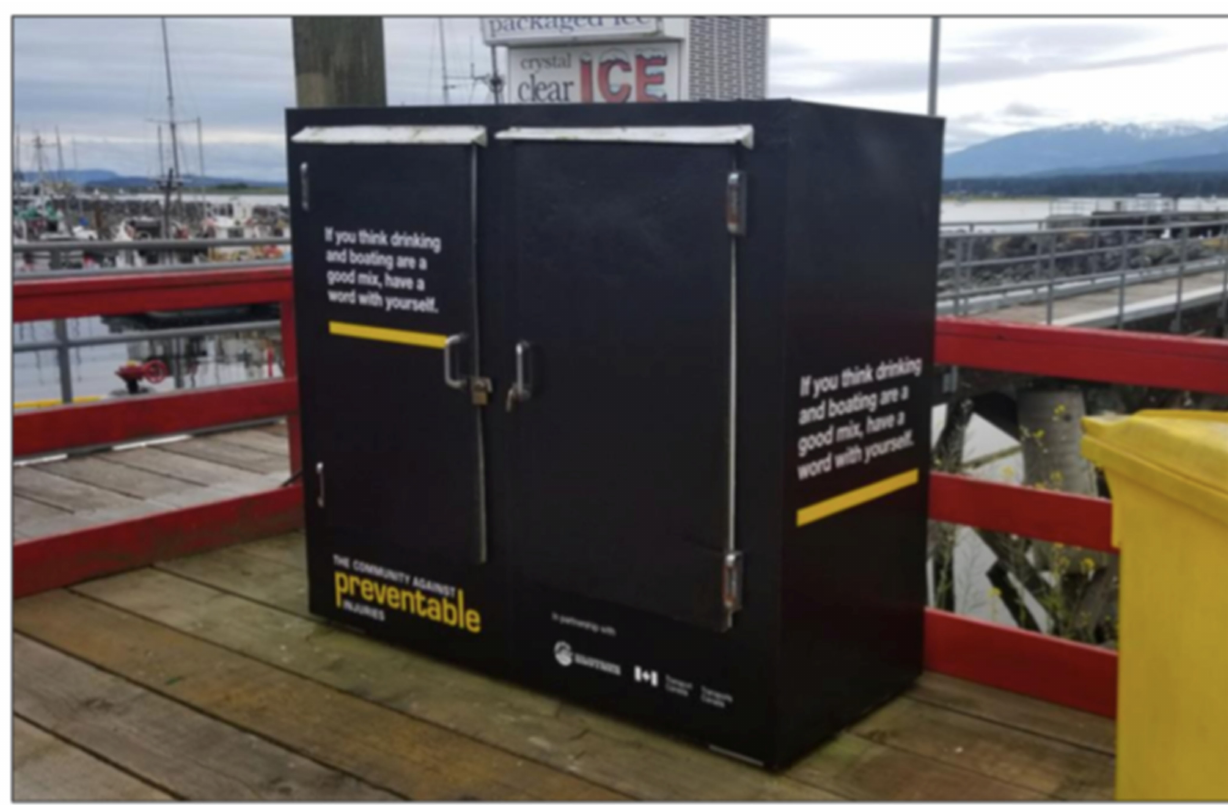
Figure 1. An example of campaign messaging placement at a high-traffic area in the marina. Ten Facebook posts were published during the two campaign periods, seven in 2018 and three in 2019, as part of the multi-media campaign